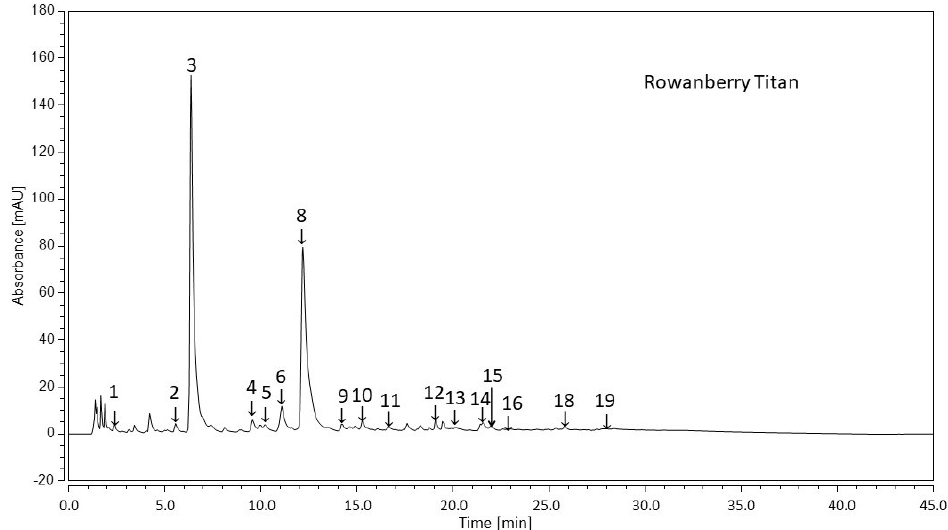
Figure 2. The profile of polyphenolic compounds in sweet rowanberry ‘Titan’: gallic acid (1), protocatechuic acid (2), neochlorogenic acid (3), 4–hydroxybenzoic acid (4), epigallocatechin (5), catechin (6), vanillic acid (7), chlorogenic acid (8), caffeic acid (9), syringic acid (10), epicatechin (11), p–cumaric acid (12), ferulic acid (13), sinapic acid (14), ellagic acid (15), rutin (16), t–cinnamic acid (17), protocatechuic acid ethyl ester (18) and resveratrol (19).